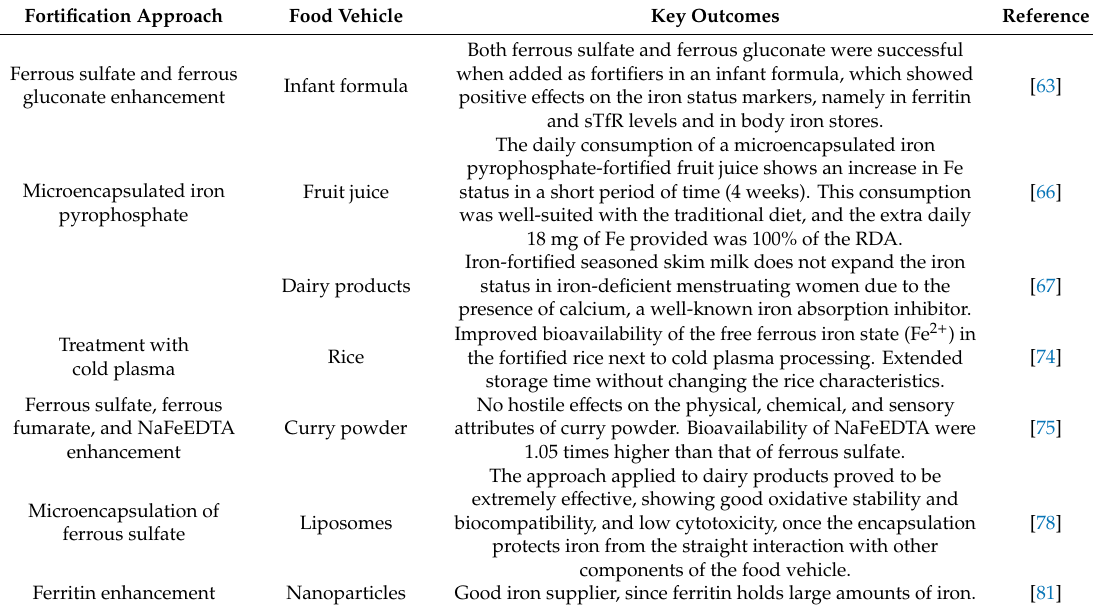
Table 2. Examples of recent studies of food fortification with